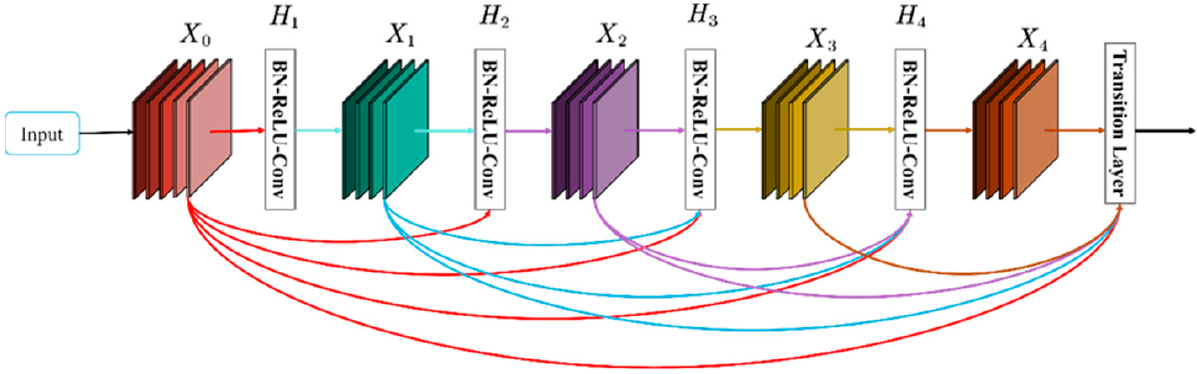
Figure 5. Five-layer dense block.